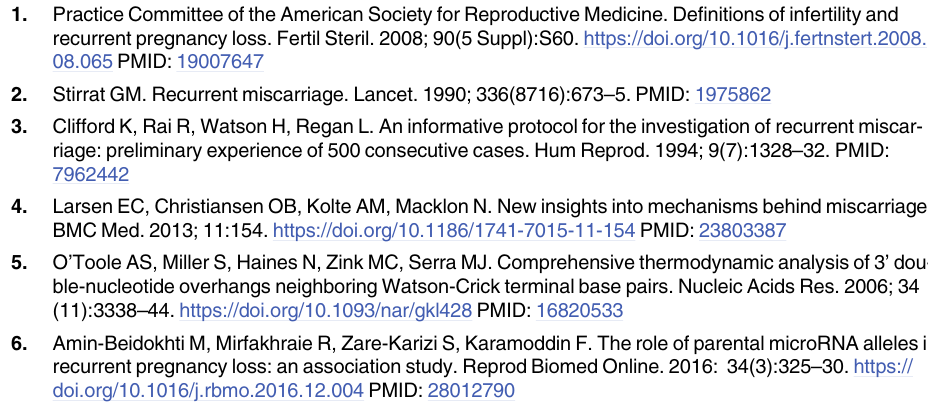
S1 Table. Haplotype-based analyses of miR-27aA > G , miR-423C > A , miR-499bA > G , and miR-605A > G polymorphisms in Korean RPL patients and control subjects for all possible allele combinations (combinations of four sites, three sites, two sites are listed respec- tively). S2 Table. Differences of clinical parameters according to the four microRNA polymor- phisms in RPL patients. S3 Table. Differences in clinical parameters according to the haplotypes of the four micro- RNA polymorphisms in RPL